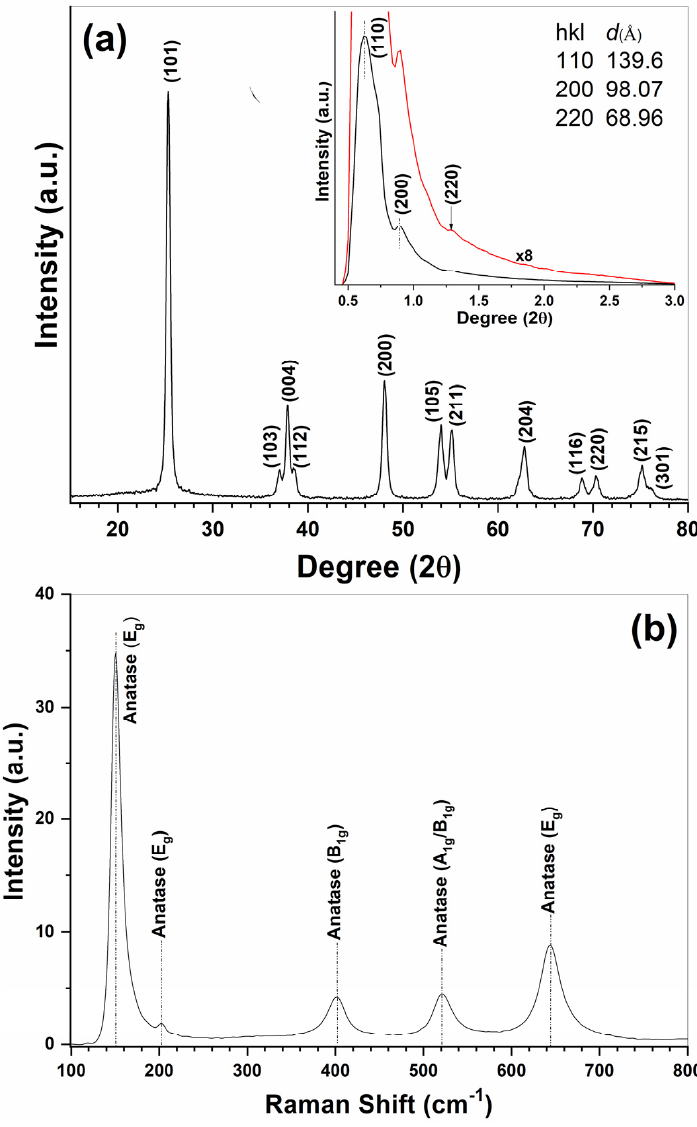
Figure 2. ( a ) Powder XRD pattern of the TS82C nanocomposite annealed at 550 °C. The inset shows low angle XRD pattern, where the hkl planes of the corresponding diffraction peaks along with the lattice spacings ( d -values) are also shown. ( b ) Raman spectra of the TS82C powder calcined at 550 °C, showing different characteristic bands of the anatase crystalline phase.